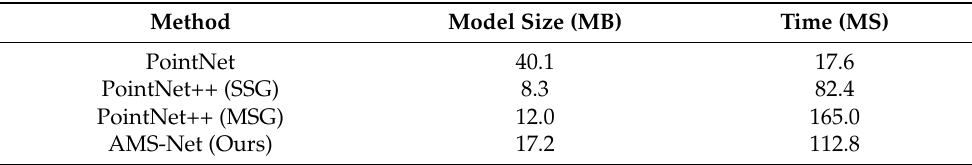
Table 3. Complexity and forward time of different models on ModelNet40.